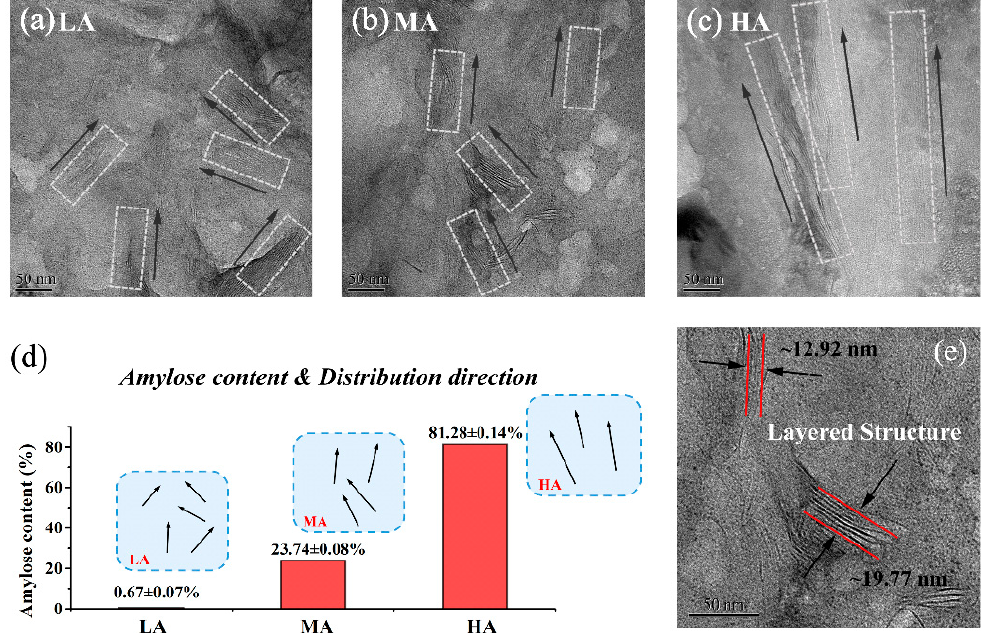
Figure 2. Nanofiller dispersion in the starch-based nanocomposites with ( a ) LA, ( b ) MA, and ( c ) HA; ( d ) the diagram of amylose content and dispersion direction; ( e ) layered structures of nanofiller.